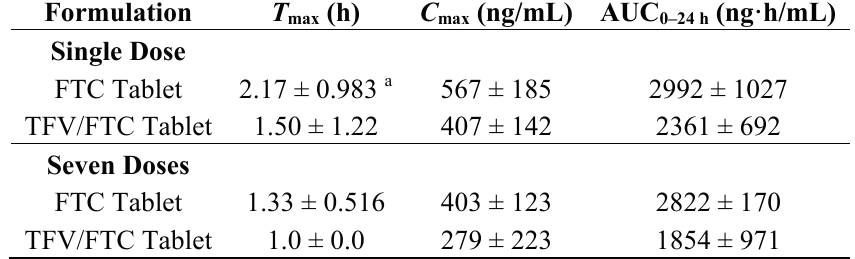
Table 4. FTC plasma PK parameters following intravaginal administration of FTC tablets (10 mg) or TFV/FTC tablets (10 mg/10 mg) after a single dose and seven once-daily